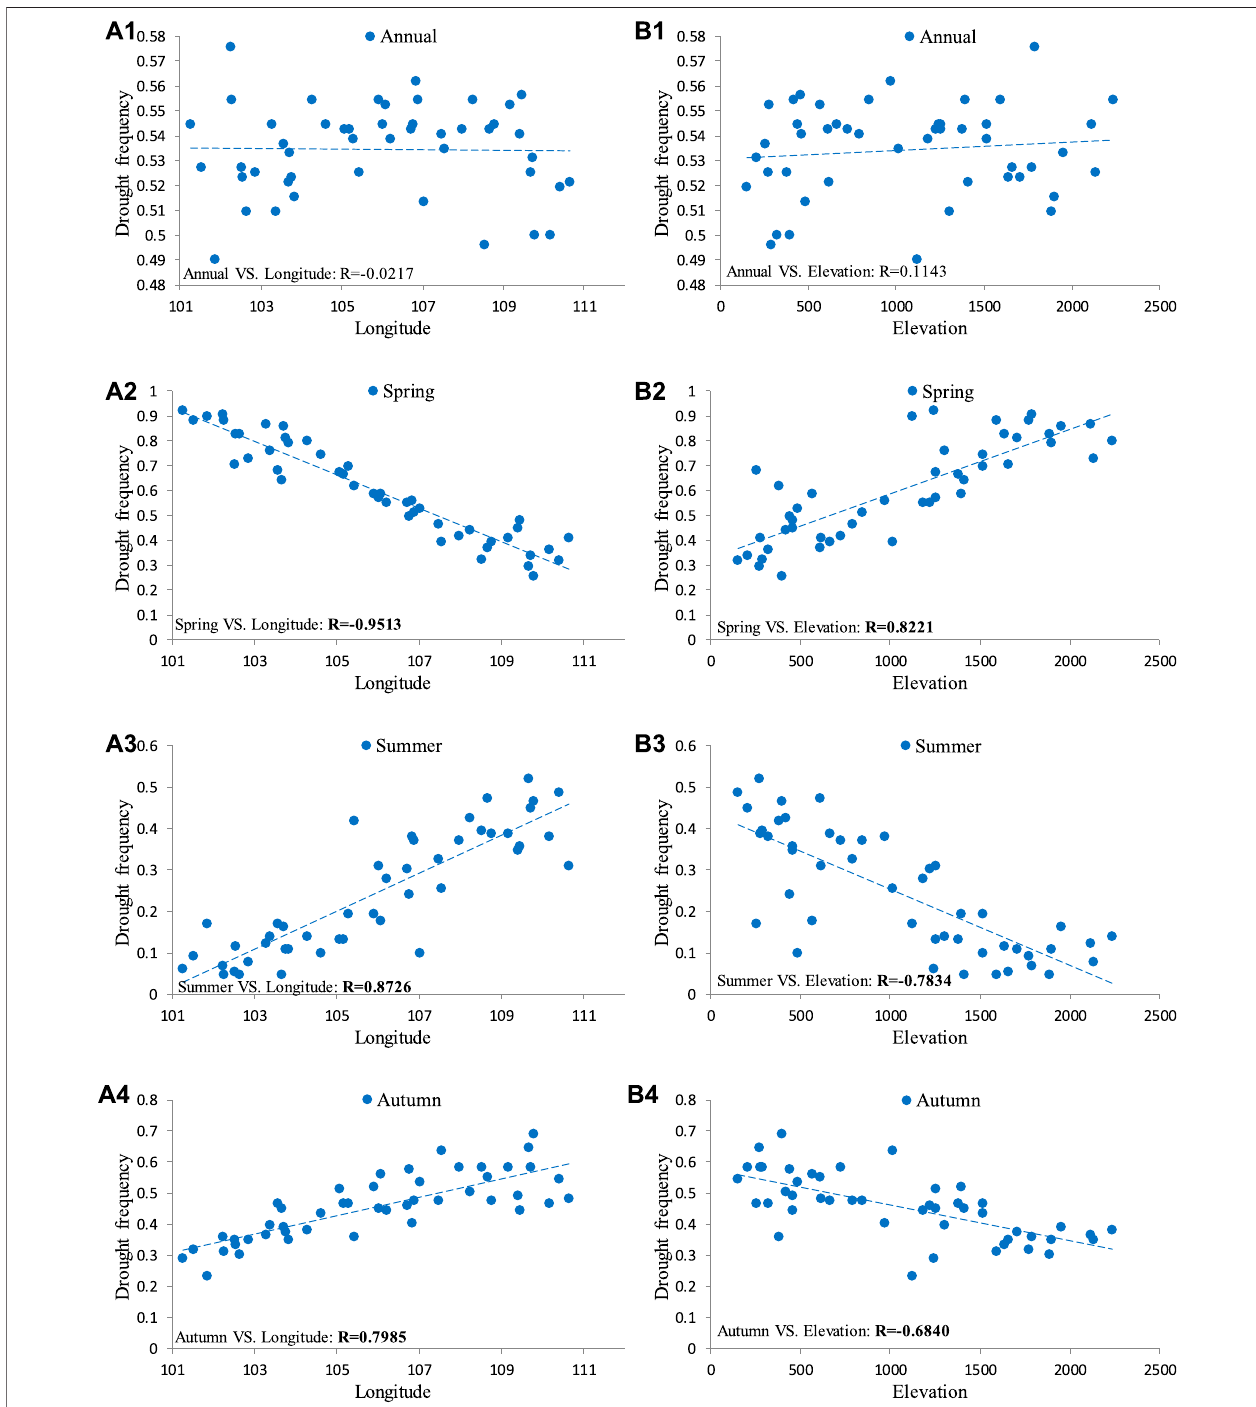
FIGURE 13 | Correlations between annual and seasonal drought frequency and longitude and elevation. (A1 – A7) represents the correlation between drought frequencyofannual,spring,summer,autumn,winter,rainyseason,dryseasonandlongitude; (B1 – B7) representsthecorrelationbetweendroughtfrequencyofannual, spring, summer, autumn, winter, rainy season, dry season and elevation. R represents the correlation coef fi cient, and the bold fonts indicate that the con fi dence level is α (cid:1) 0.001.